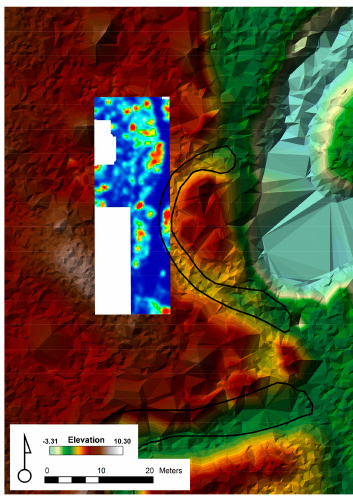
Figure 18. LiDAR map overlain with GPR data showing a feature that may potentially represent the remains of San Felipe (II). LiDAR data were processed in ArcMap 10.2 with the LAS toolset using the NAD 1983 and NAV 1988 horizontal and vertical datum,